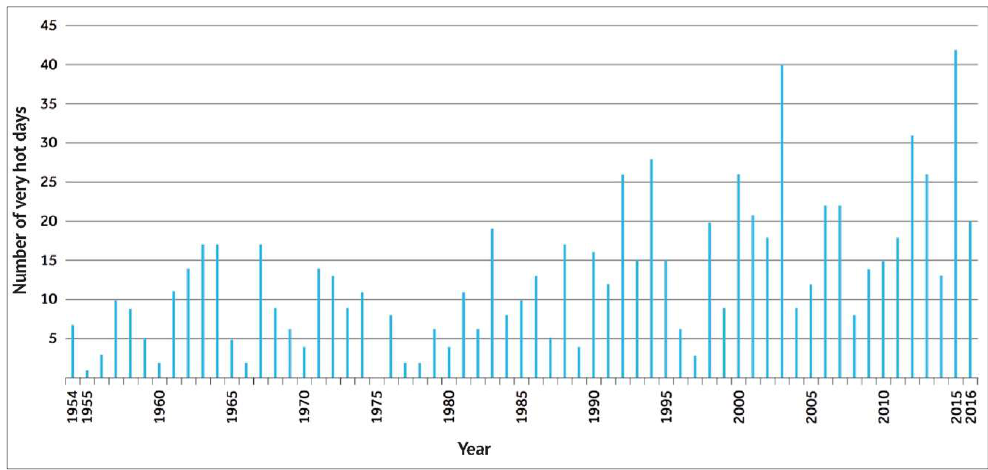
Figure 1. Number of “very hot days” (days with equal or higher temperatures than 30 °C) in Vienna in the period 1954–2016; graphic based on data from ZAMG (Zentralanstalt für Meteorologie und Geodynamik) [18].